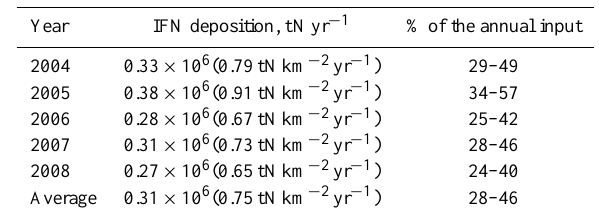
Table 1. The deposition of IFN at the Black Sea